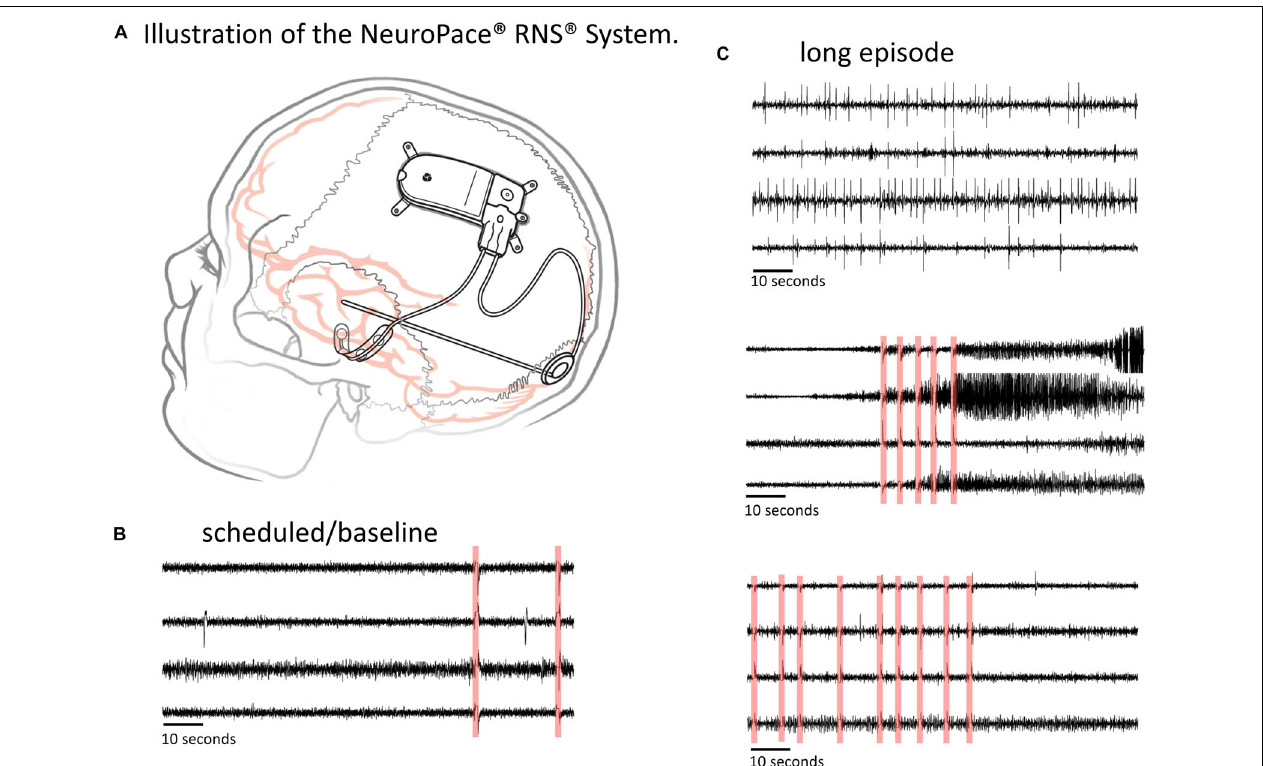
FIGURE 1 | The RNS System and types of ECoG data captured. (A) Illustration of the NeuroPace RNS System. The neurostimulator is placed in the skull and connected to up to two leads, each of which contains four electrode contacts. The leads can be cortical strip leads, depth leads or a combination. (B,C) Examples of 4-channel electrocorticographic (ECoG) records for a single patient captured with the RNS System. (B) Scheduled/baseline ECoG record. (C) ‘Long Episode’ (LE) ECoG records (i.e., ECoG records with detection of long abnormal patient-specific patterns). LE ECoG records can contain a variety of abnormal ECoG activity on one to several ECoG channels. Stimulation artifacts are highlighted in red in panels (B,C) . Stimulation artifact consists of short blanks in data followed by a brief amplifier recovery